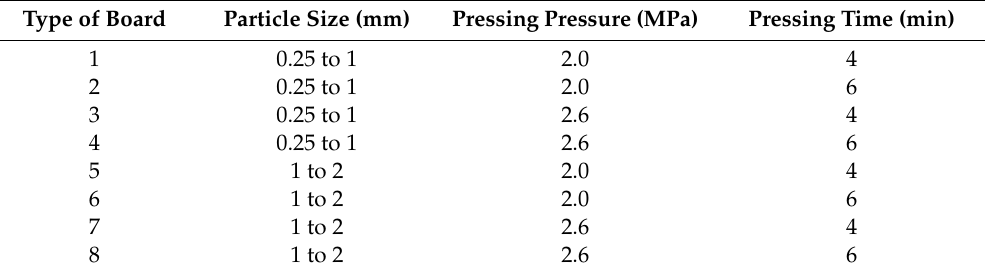
Table 1. Types of board manufactured.